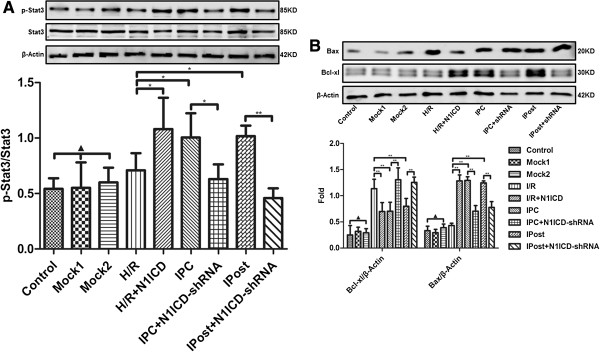
Notch1 signaling regulates Stat3 phosphorylation and the expression of Bcl-xl and Bax in H9c2 cells exposed to ischemia. A, The phosphorylation of Stat3 in different groups of H9c2 cells. B, The expression of Bcl-xl and Bax in different groups of H9c2 cells. β-actin was loading control. Data were presented as mean±SD, n=3. Mock1 indicated cells infected with empty vector, Mock2 indicated cells infected with vector containing nonspecfic sequences. ▲P>0.05, *P<0.05, **P<0.01.